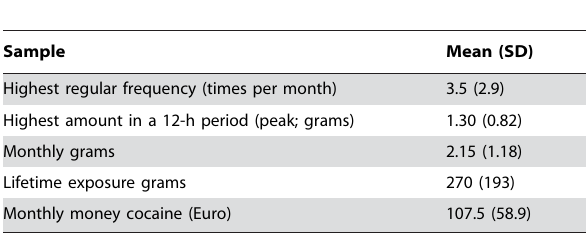
Table 2. Self-reported use of cocaine. Standard deviation in